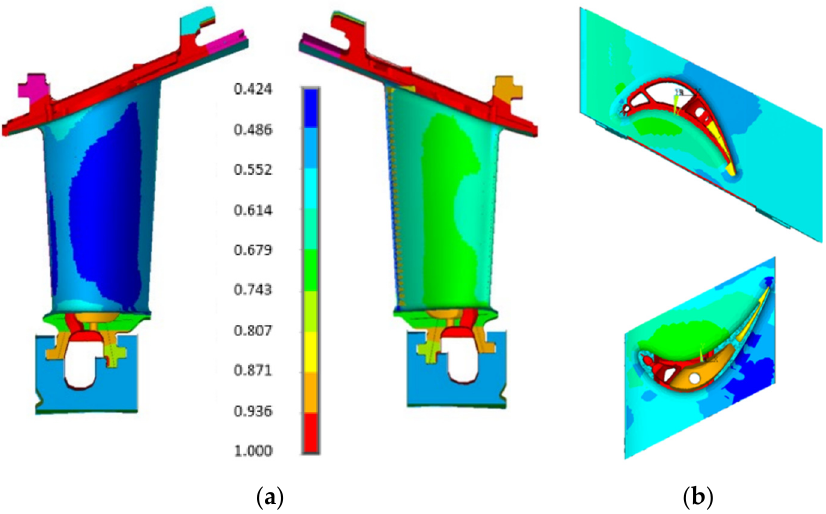
Figure 3. Mechanical load distribution on the turbine vane: ( a ) pressure distribution along the external airfoil; ( b ) pressure distribution along the outer and inner platforms.